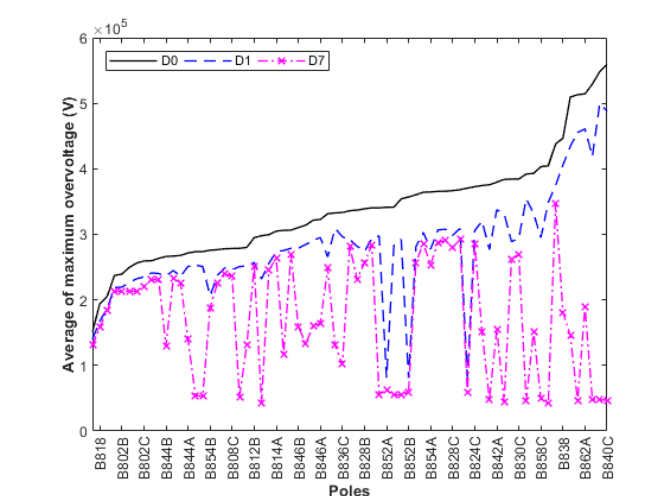
Figure 25. Average values of maximum overvoltages for m = 0.5 and n = 0.5: without lightning arresters (D0); lightning arresters at the transformer’s pole only (D1); and lightning arresters at the transformer’s pole and at the six most critical poles (D7).